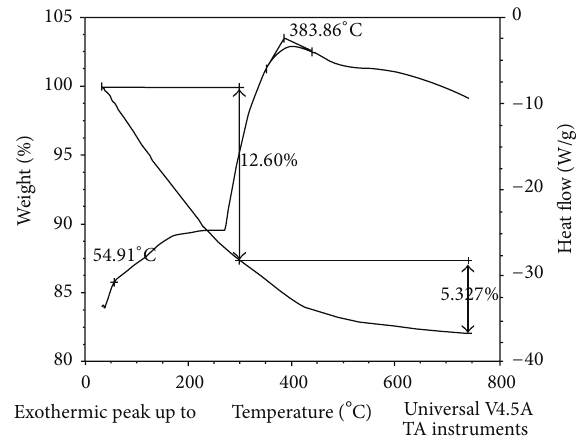
Figure 4: TGA and DSC of 1a sample.